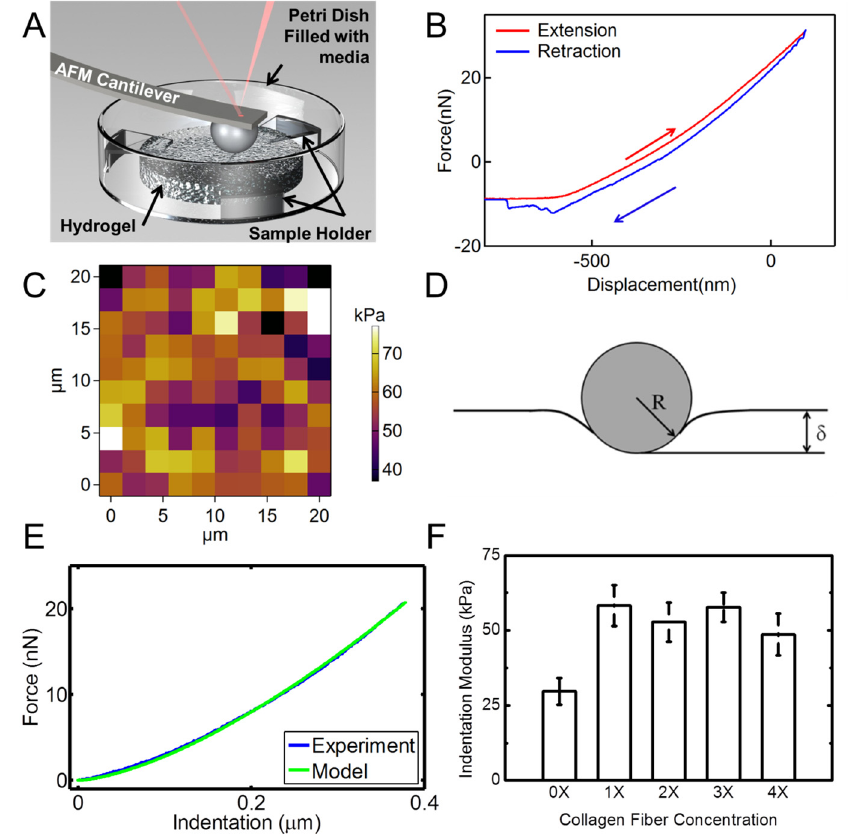
Figure 6. AFM nanoindentation experiments on hydrogel specimens. ( A ) Schematic shows the setup for indentation of hydrogel samples in a liquid media using a spherical probe; ( B ) A typical force-displacement (indentation depth) response from hydrogel; ( C ) Indentation map on a 20 µm × 20 µm area for a total of 100 points of a sample with 4X collagen concentration. The color bar represents the indentation modulus; ( D ) Schematic of the Hertzian contact mechanics model for spherical indentation into the hydrogel surface; ( E ) Comparison of the force-indentation data from an experiment modeled with Hertzian contact mechanics; ( F ) Indentation moduli extracted from nanoindentation experiments for hydrogel samples with different concentrations of collagen fibrils. Error bars in ( F) are SD for five measurements at each